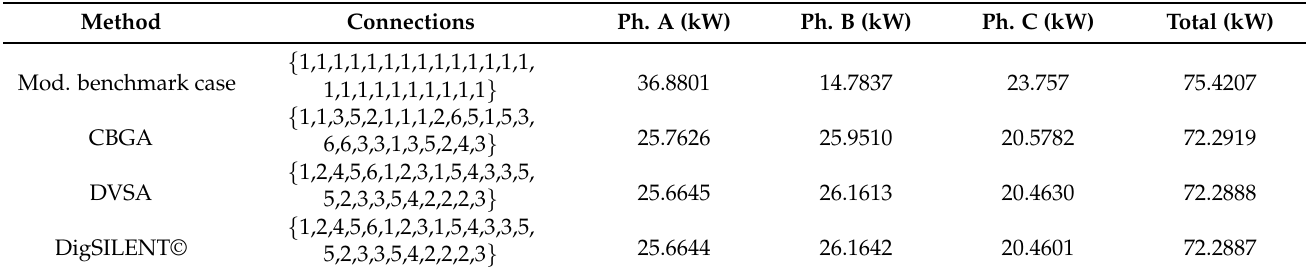
Table 12. Results of the optimal phase-balancing for the 25-node test